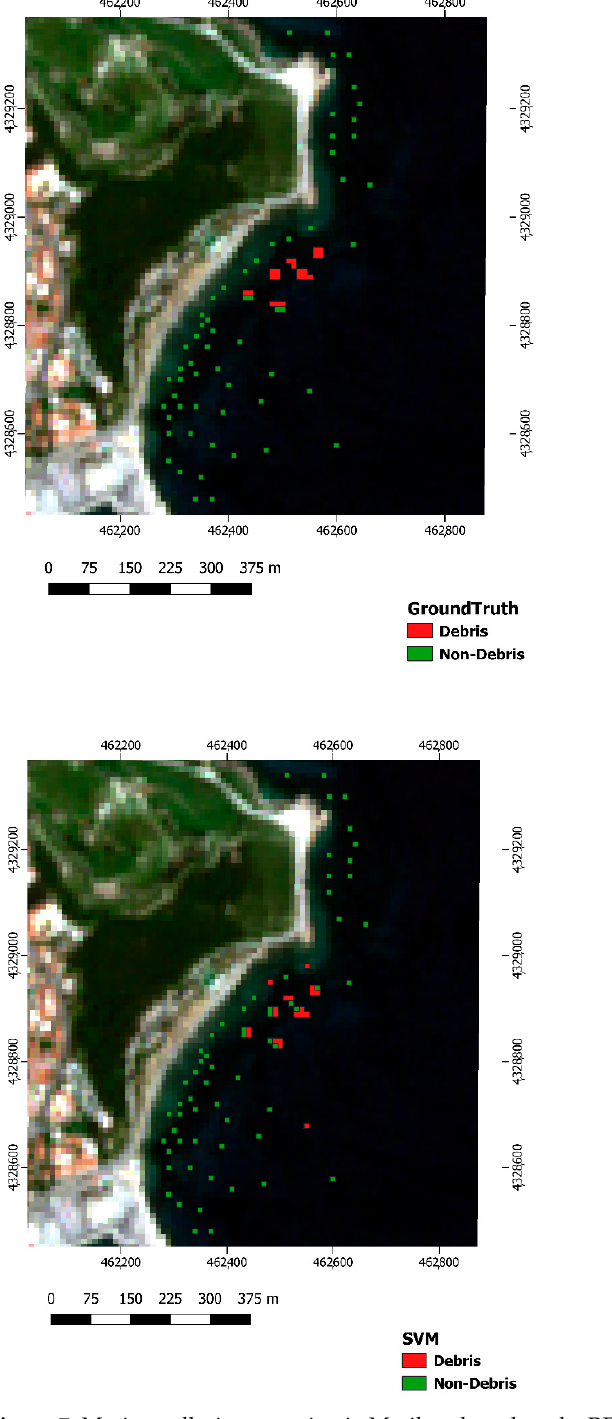
Figure 7. Marine pollution mapping in Mytilene based on the RF ( top right image ), SVM ( bottom left image ), and GAN-RF ( bottom right image ) algorithms.